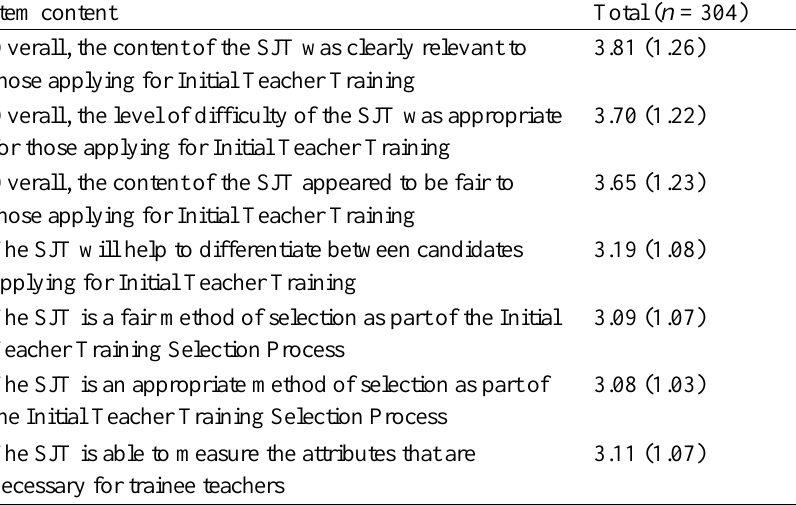
Participant Evaluation Responses for Teacher Situational Judgment